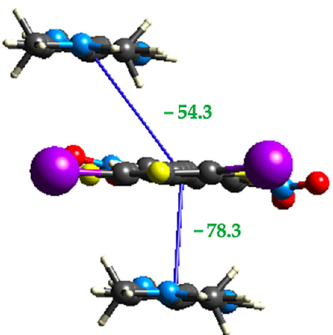
Figure 14. Crystal Explorer interaction energies (in kJ/mol) for the two π -stacking interactions within the cocrystal 2 • 3 . Table 3. Interaction energies (in kJ/mol) for the unique stacking interactions in cocrystal 2 • 3